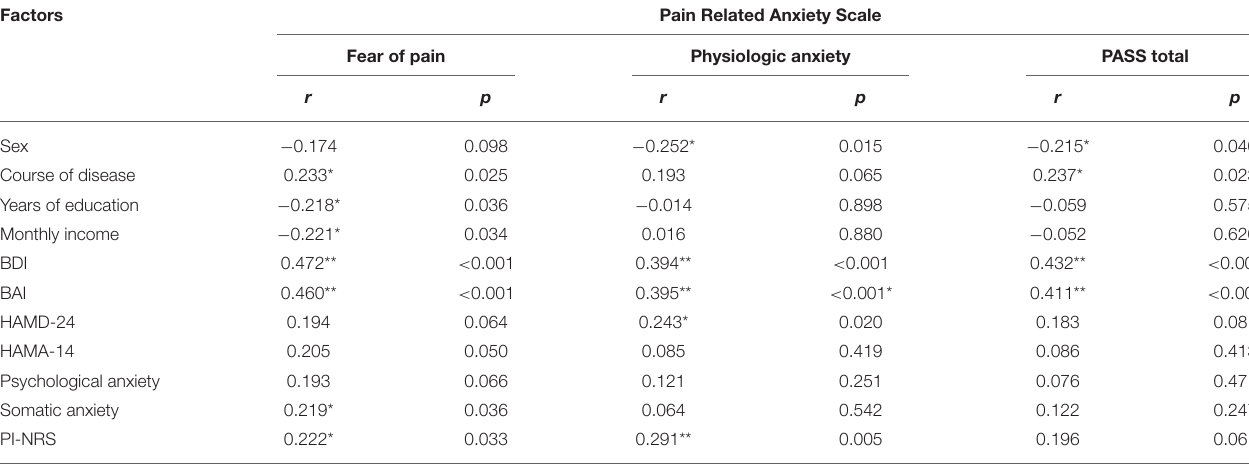
TABLE 3 | Factors correlation with pain-related anxieties. Factors Pain Related Anxiety Scale